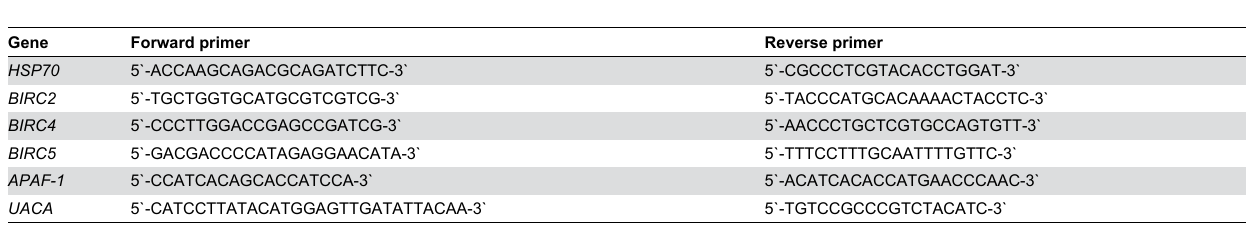
Table 1. Primers used for real-time RT-PCR quantification of expression of the investigated transcripts.